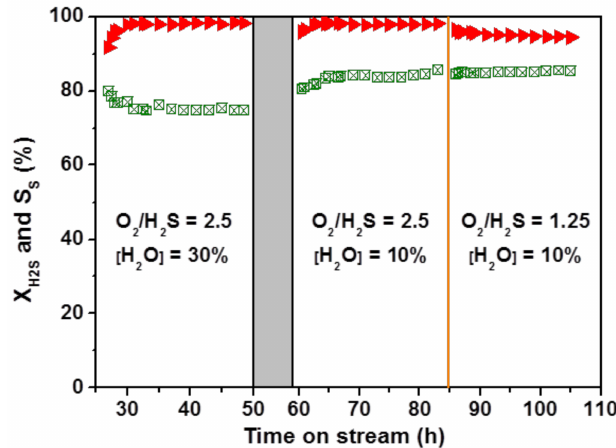
Figure 10. Influence of the steam concentration and O 2 -to-H 2 S ratio on the desulfurization performance on the pristine GFs and the one after treatment under gaseous HNO 3 at 250 ◦ C for 16 h (OGFs-16) catalysts. Reaction conditions: [H 2 S] = 1 vol. %, reaction temperature = 250 ◦ C and WHSV = 0.05 h − 1 .